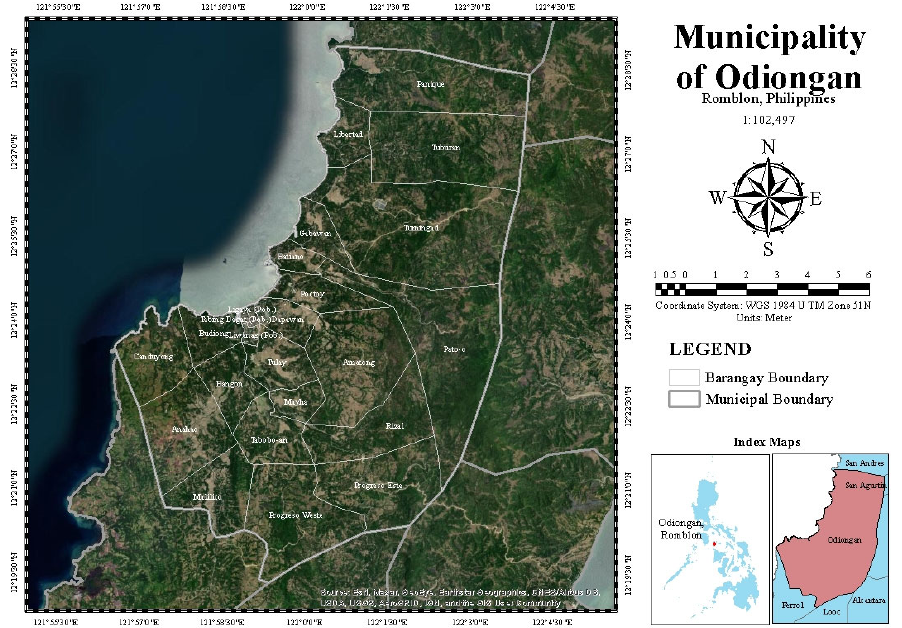
Figure 1. Imagery map with barangay and municipal boundaries of the study area.